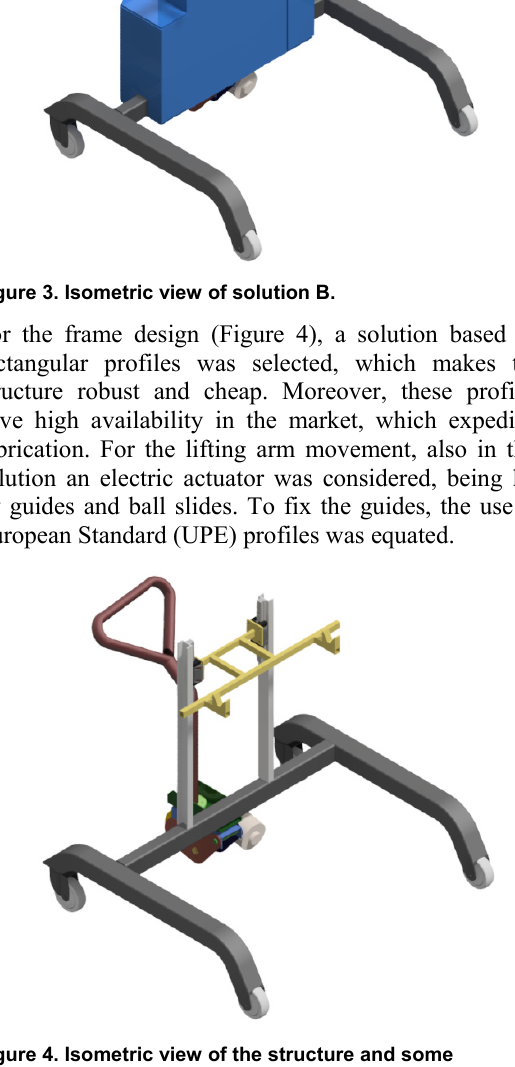
Figure 4. Isometric view of the structure and some components of solution B.